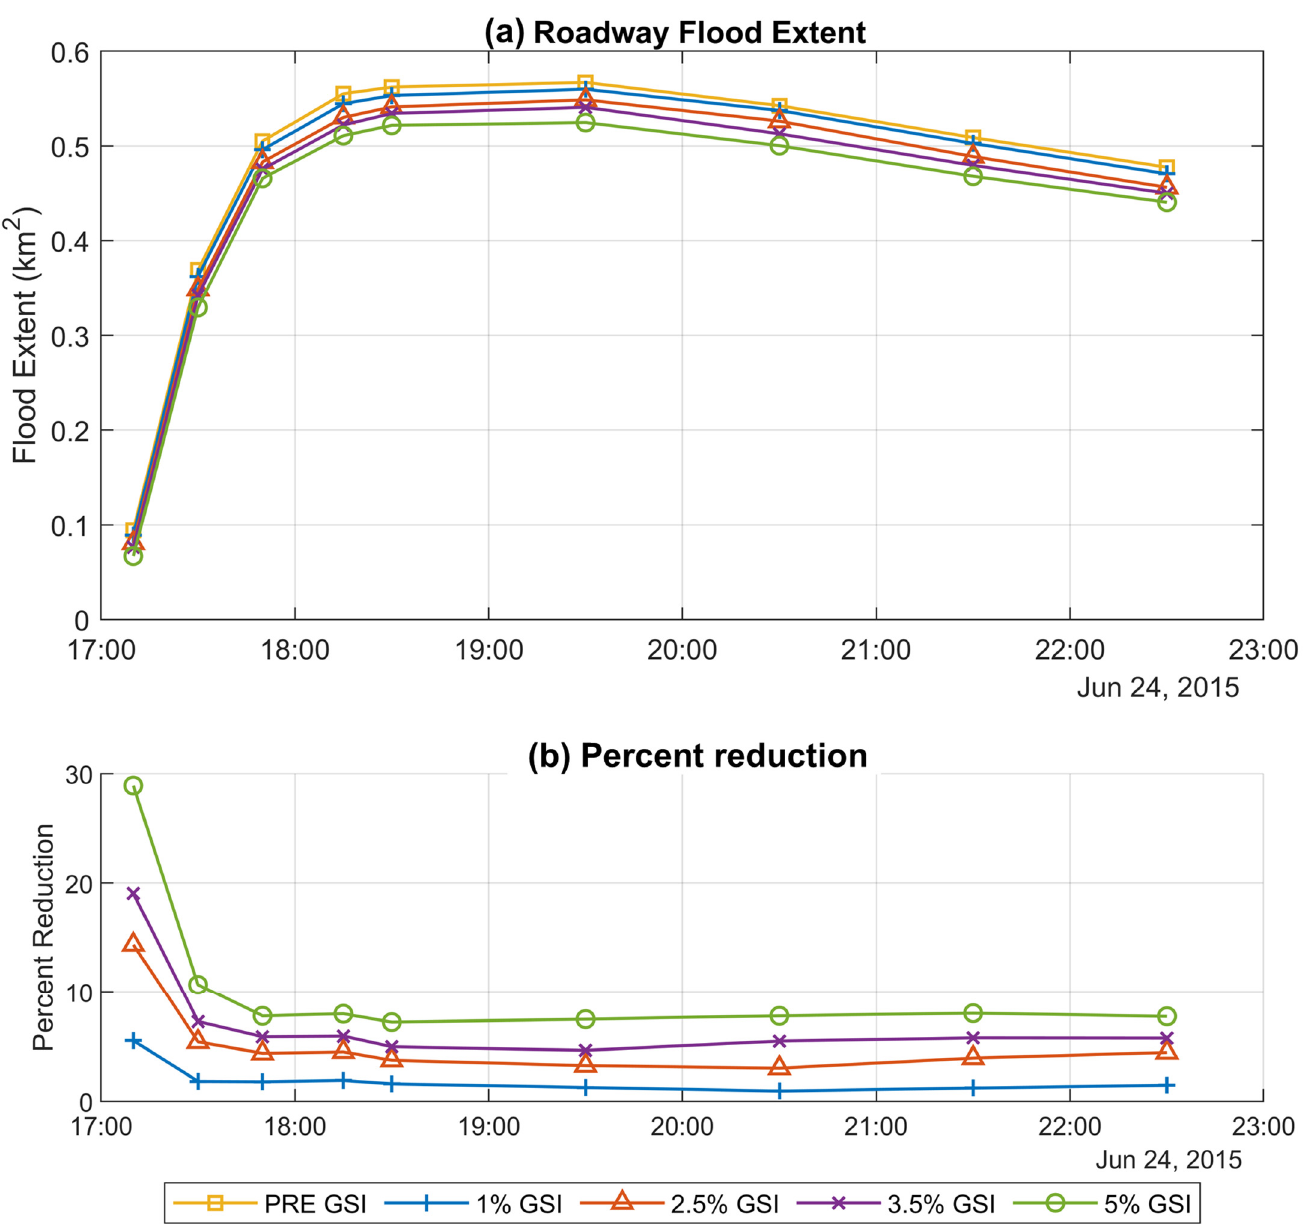
Figure 5. ( a ) Roadway flood extent (km 2 ) at select times throughout the simulation period; ( b ) Percent reduction in roadway flood extent for GSI scenarios compared to the pre-GSI scenario.